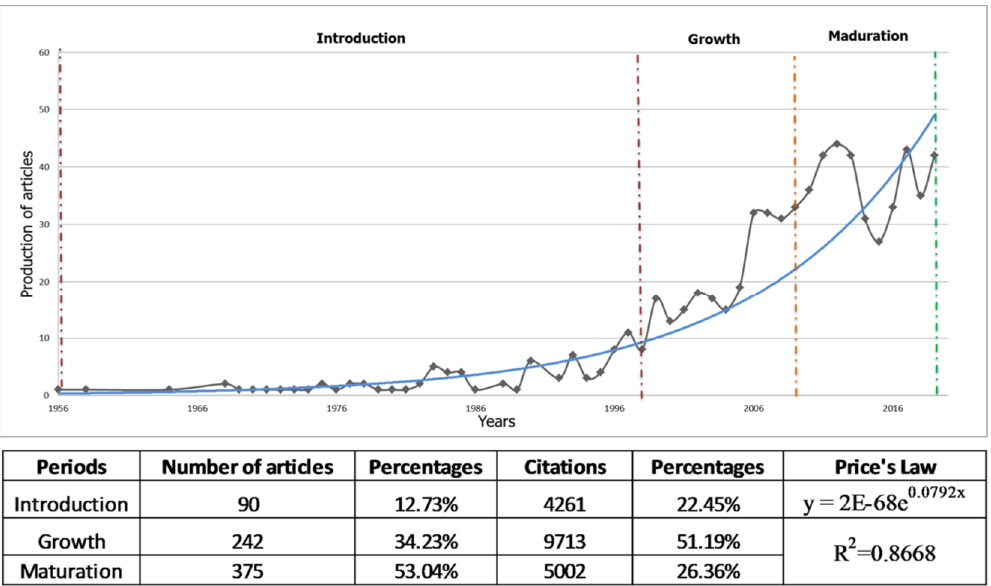
Figure 2. Scientific production table of volcanic geomorphology articles.